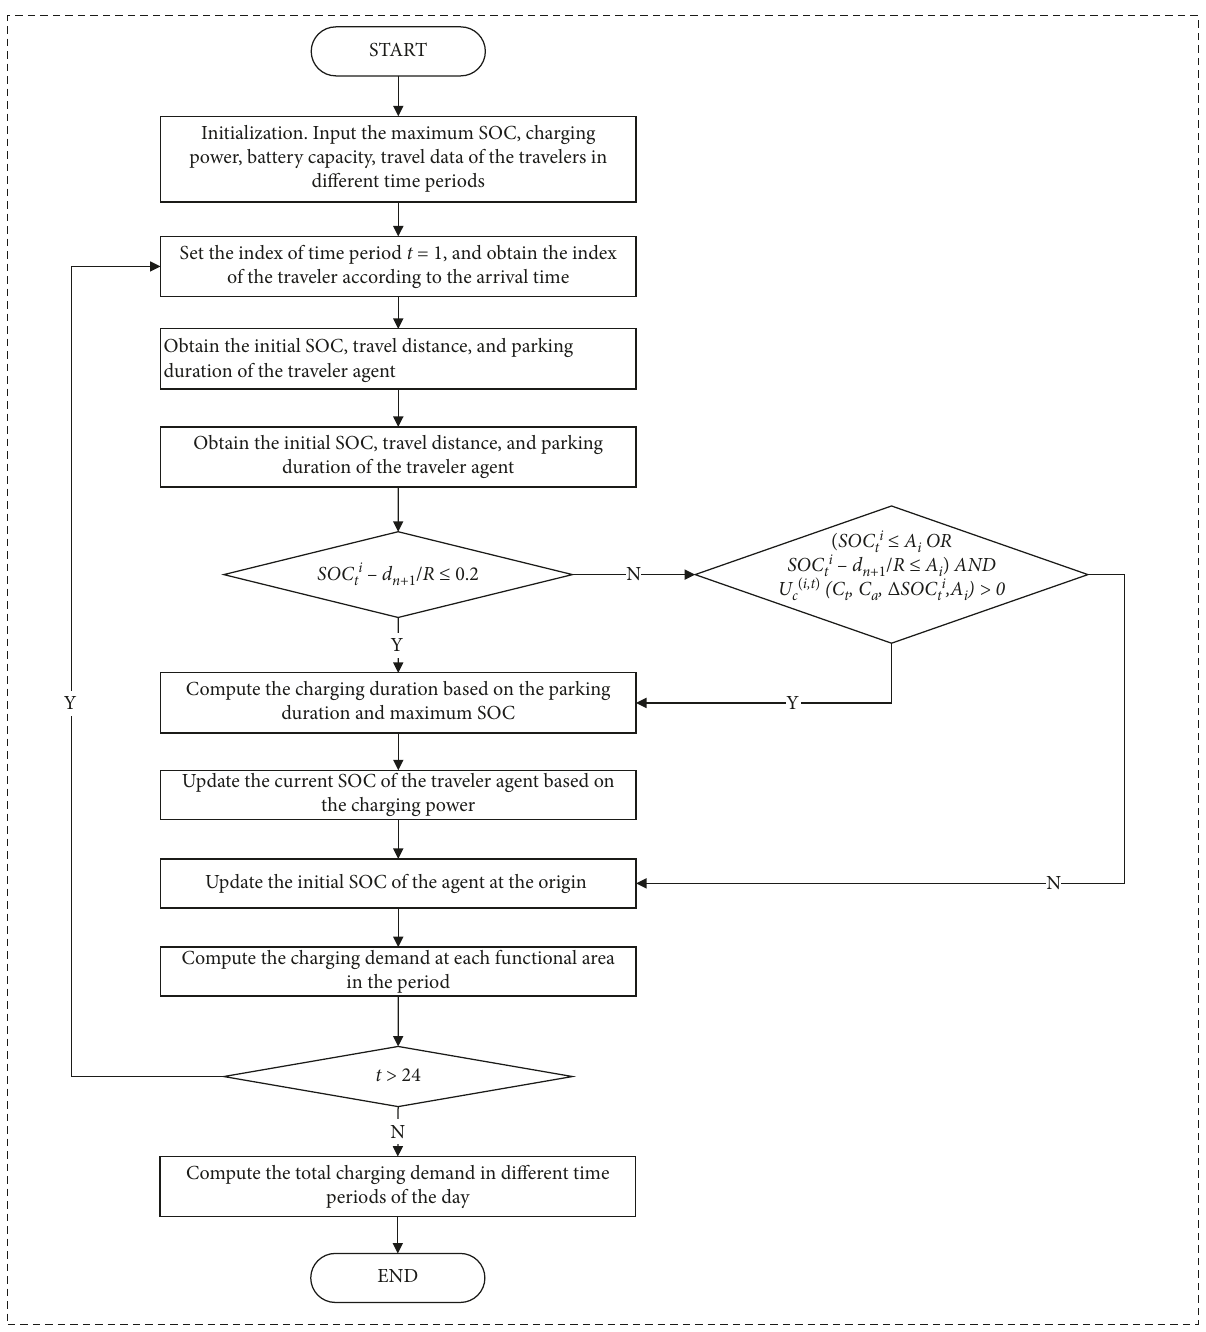
Figure 3: Simulation of charging demand